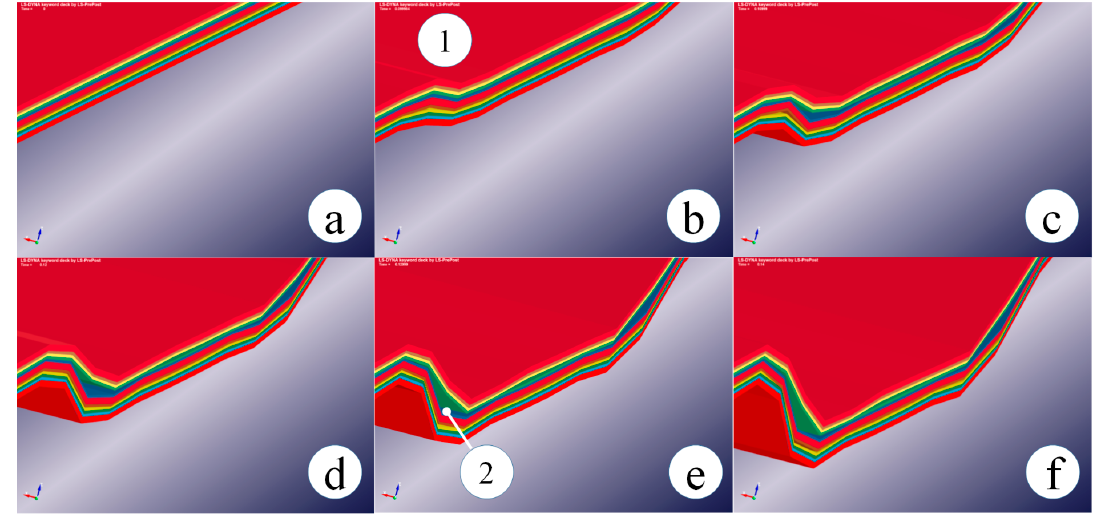
Figure 7. Sub-laminates through the GLARE thickness attributed to delamination at ( a ) 0 ms (initial state), ( b ) 0.099 ms, ( c ) 0.11 ms, ( d ) 0.12 ms, ( e ) 0.13 ms, ( f ) 0.14 ms; 1 indicates the impacted side;